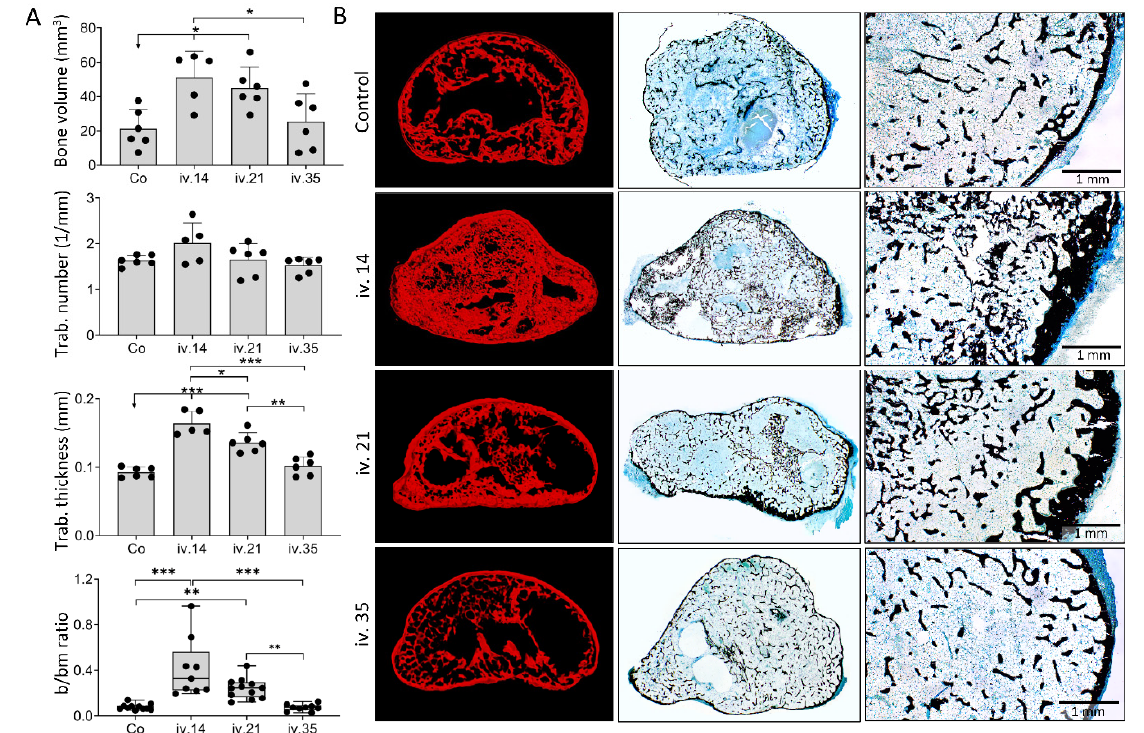
Figure 5. ZOL applied intravenously on day 14 or 21 increased bone volume and affected bone microarchitecture on day 50 following subcutaneous implantation of ABGS (rhBMP6/ABC) implants without ceramics. ( A ) MicroCT parameters including bone volume (mm 3 ), trabecular number (1/mm), trabecular thickness (mm), and the histomorphometrically determined bone/bone marrow (b/bm) ratio were observed among the experimental groups on day 50. ZOL was applied intravenously (i.v.) on day 14, 21, or 35. Implants without ZOL served as a control (Co) group. ( B ) Newly formed bone (red) is shown on 3D reconstruction slices among experimental groups. Histological (Von Kossa stain) sections through the newly formed bone (stained black) on day 50 induced by implants without ZOL (Co) or with ZOL applied intravenously (i.v.) on day 14, 21, or 35. Scale bars are shown in the lower right corner. All P values below 0.05 were considered significant and are marked with asterisks as follows: * ( p ≤ 0.05), ** ( p ≤ 0.01), *** ( p ≤ 0.001).